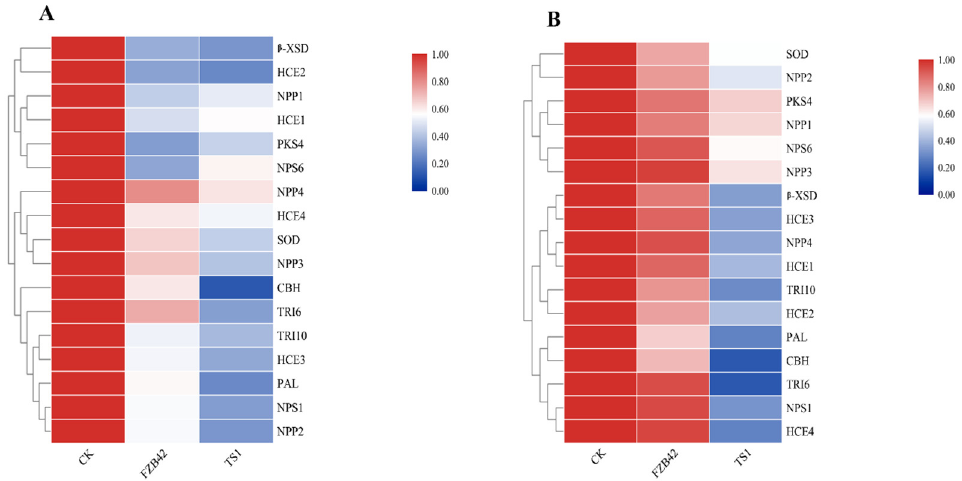
Figure 6. Quantitative real-time PCR expression analysis of pathogenicity-related genes of fungal pathogen F. graminearum under treatment of Bacillus strains FZB42 and TS1 at ( A ) normal condition 25 °C and ( B ) cold condition 15 °C. The qPCR experiment for expression studies was repeated thrice with similar results.